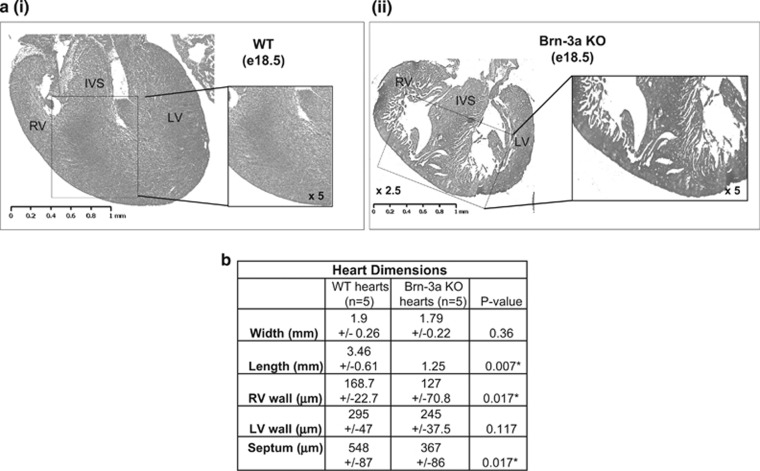
(a) Representative H+E-stained heart sections from e18.5 embryos taken from either (i) WT or (ii) Brn-3a KO mutants. Images were taken at × 2.5 or × 5 (box). (b) Cardiac dimensions were measured in heart sections taken from Brn-3a KO or WT control hearts at e18.5 which were stained with H&E then scanned using the whole-slide imaging function on The Hamamatsu Nanozoomer. Images were analysed using the NDP view 2 software to measure heart width (across left and right ventricles), length (base to apex), right or left ventricular wall thickness (RV or LV wall) and septal thickness. Values shown represent the mean and S.E. of measurements from at least 5 independent hearts. H+E, haematoxylin and eosin; IVS, interventricular septum; LV, left ventricle; RV, right ventricle; Wt, wild-type